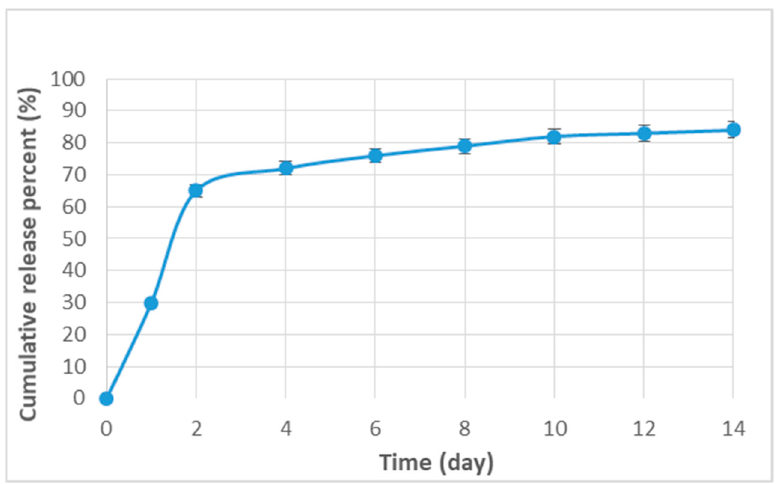
Figure 3. The release pattern of curcumin from hydroxyapatite–gelatin/curcumin nanocomposites.